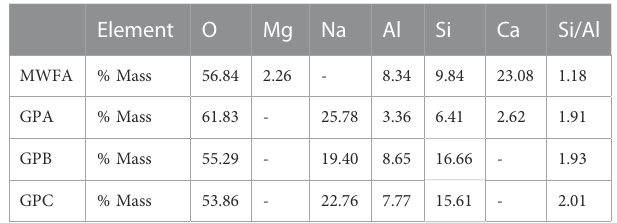
TABLE 1 EDX elemental